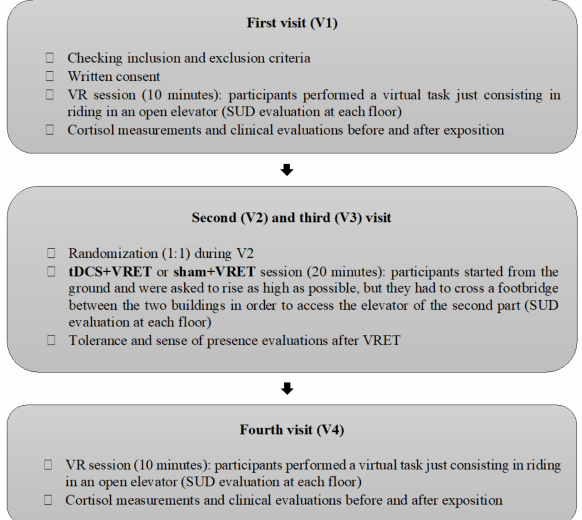
Figure 2. Flow-Chart. Abbreviations: SUD: Subjective Unit of Discomfort; tDCS: transcranial Direct Current Stimulation; VRET: Virtual Reality Exposure Therapy; VR: Virtual